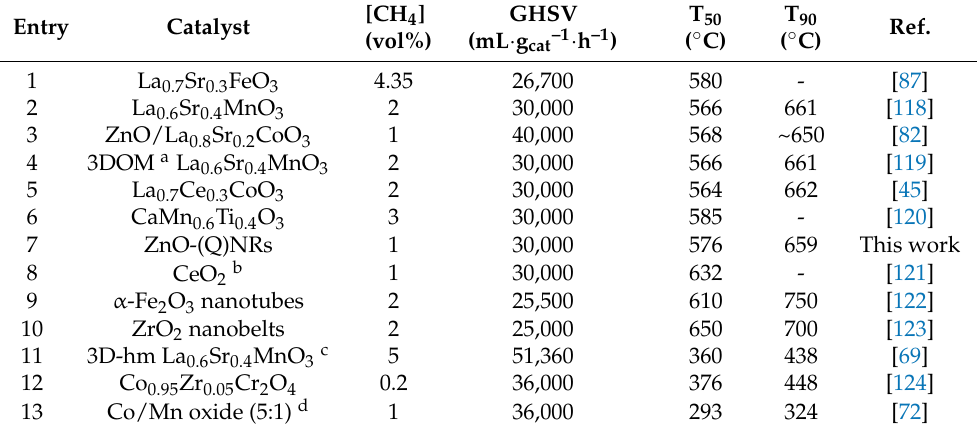
a 3DOM: three-dimensionally ordered macroporous structure. b Sample with 15.7 m 2 · g − 1 . c